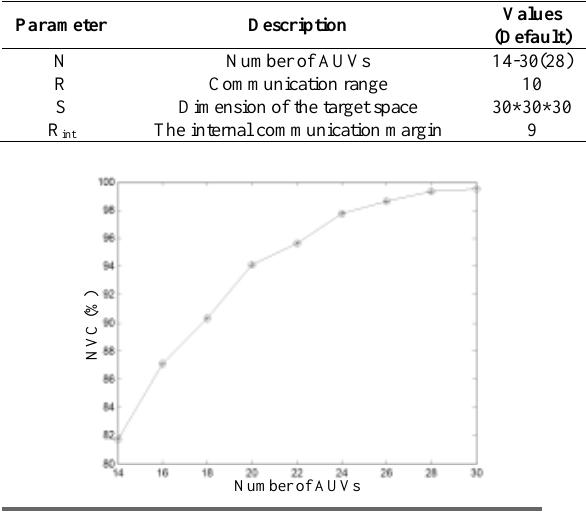
Table 1. Parameters in all experiments.